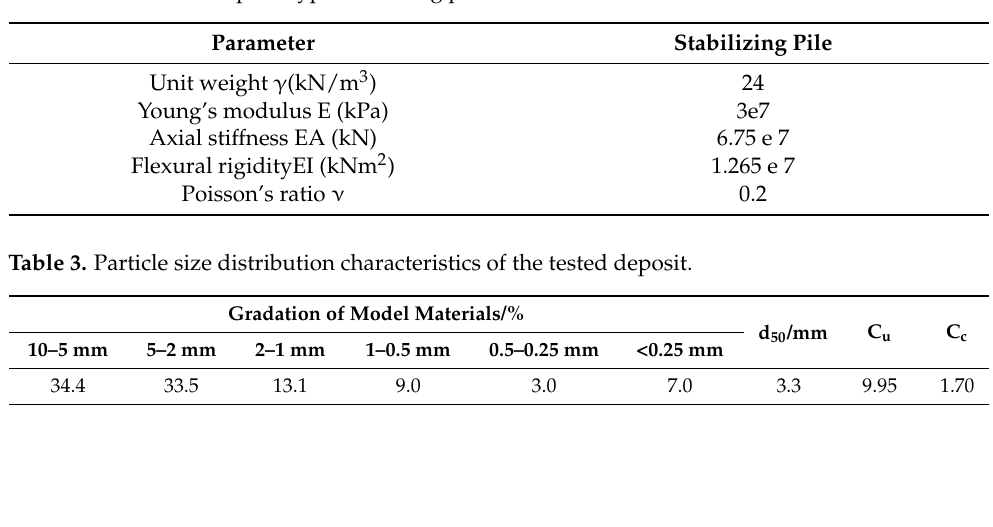
Figure 1. Layout of model slope and instrumentation at model-scale: ( a ) 1# model; ( b ) 2# model; ( c ) layout of earth pressure cells and strain gauges on a model pile (unit: mm). Table 2. Parameters of prototype stabilizing pile.